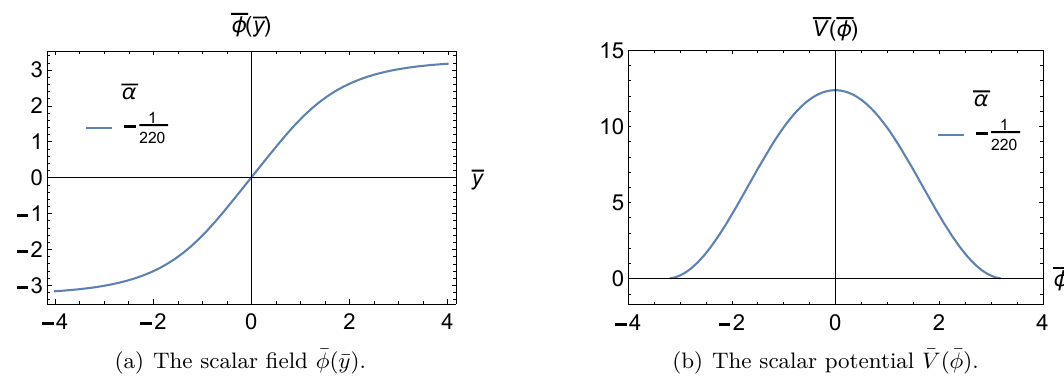
Figure 3 . Plots of the dimensionless scalar field ¯ φ (¯ y ) at the critical value ¯ α c and the corresponding dimensionless scalar potential ¯ V (¯ φ ) . The parameter n is set to 1